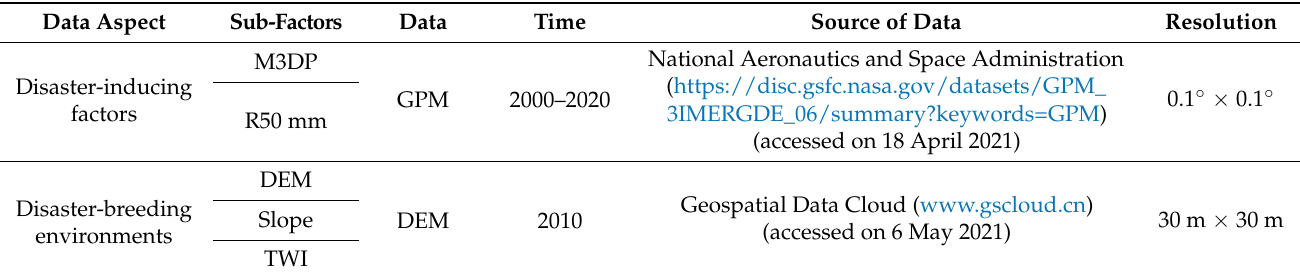
Table 1. Primary sources for the factors used for flood assessment in this study.